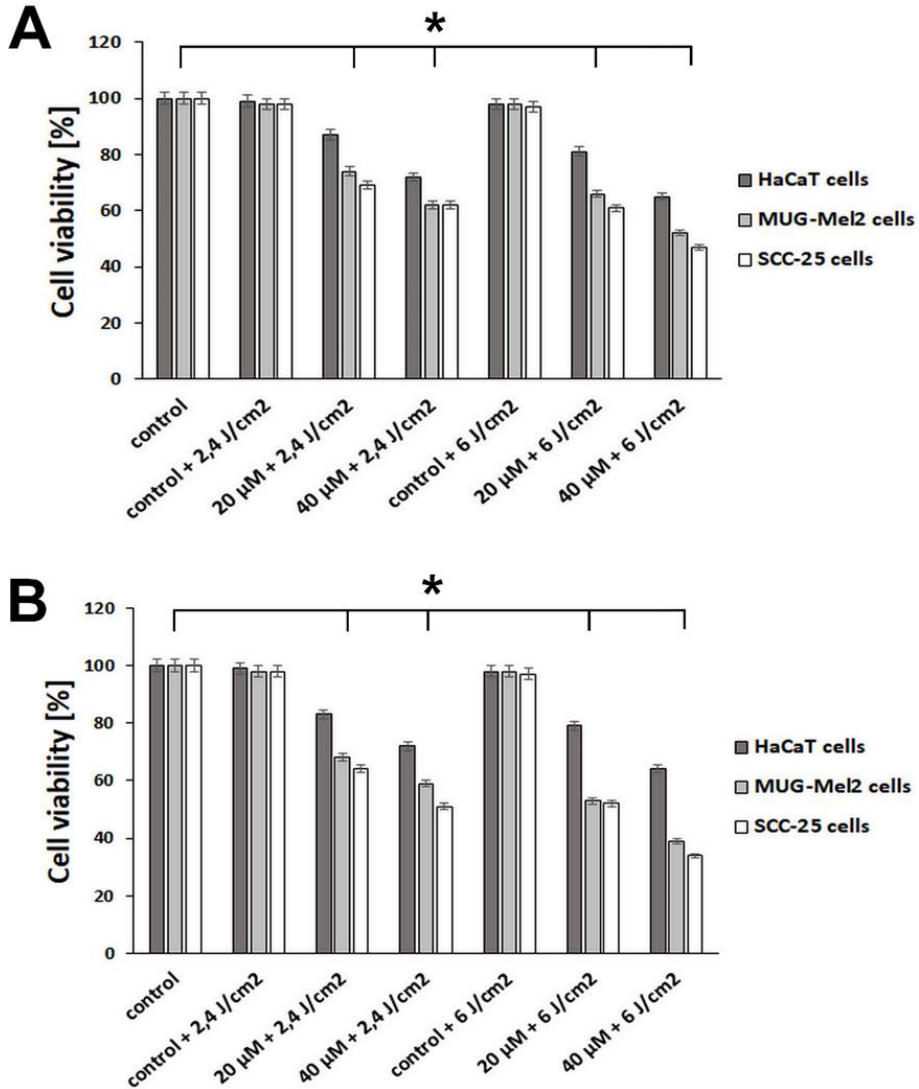
Figure 3. Comparison of HaCaT, MUG-Mel2, and SCC- 25 cells viability after 24 h incubation with ( A ) emodin-based PDT or ( B ) aloe-emodin- based PDT at concentrations of 20 μM and 40 μM after blue light low irradiation (2.4 J/cm 2 ) or medium irradiation (6 J/cm 2 ). Results represent the mean from three different experiments from four wells. * p < 0.05.